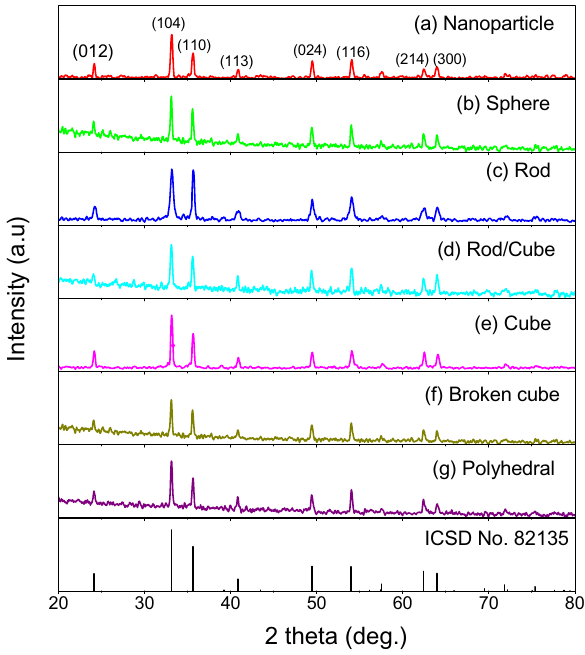
Figure 1. XRD patterns of α-Fe 2 O 3 synthesized via hydrothermal route at various concentration ratios of FeCl 3 and cetyltrimethylammonium bromide (CTAB) ( C FeCl 3 / C CTAB ) : ( a ) C FeCl 3 / C CTAB = 0.02 / 0.0 , ( b ) 0.02 / 0.01 , ( c